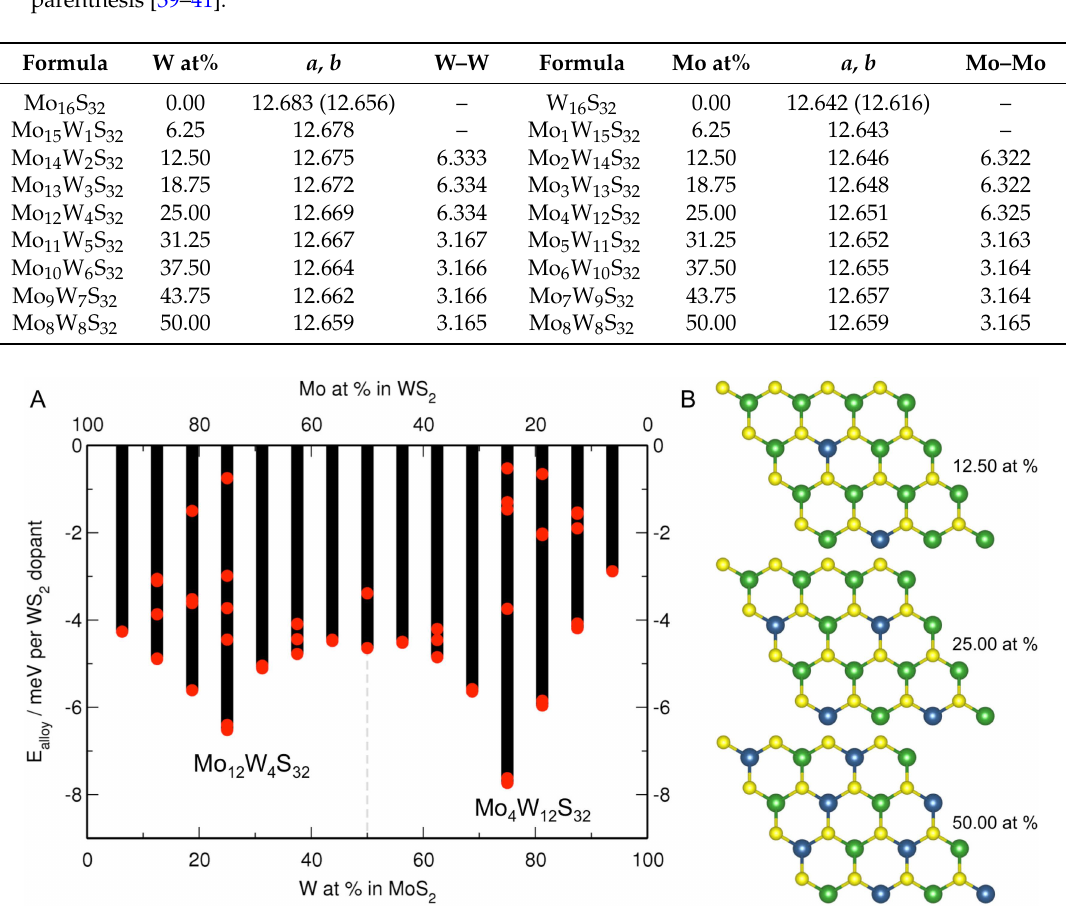
Table 1. Calculated lattice parameters a and b (Å) of the 4 ˆ 4 supercell and dopant closest distances (Å) of the most stable Mo 1 ´ x W x S 2 (or Mo x W 1 ´ x S 2 ) systems. Experimental data are given in